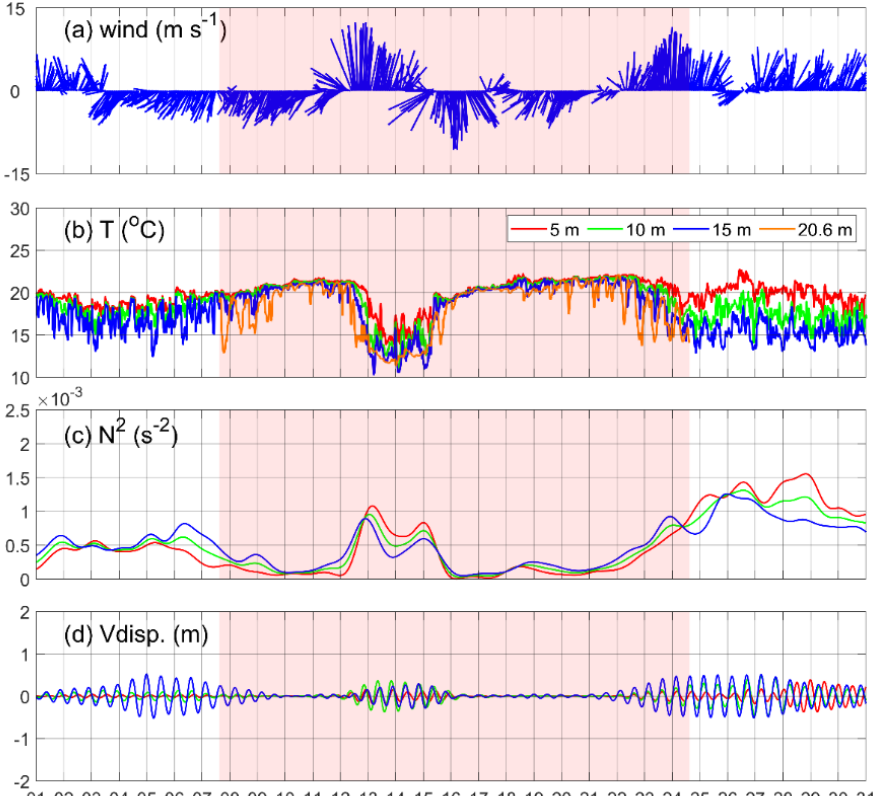
Figure 2. Timeseries of ( a ) 12 m wind speed at the light beacon; timeseries of ( b ) temperature, ( c ) buoyancy frequency, and ( d ) semidiurnal vertical displacement at depths of 5, 10, and 15 m, calculated using ocean buoy data. Red, green, and blue lines denote the depths of 5, 10, and 15 m, respectively. The orange line in ( b ) indicates the bottom temperature at a depth of 20.6 m observed by ADCP mooring, and the reddish highlight denotes the period of the ADCP observation.